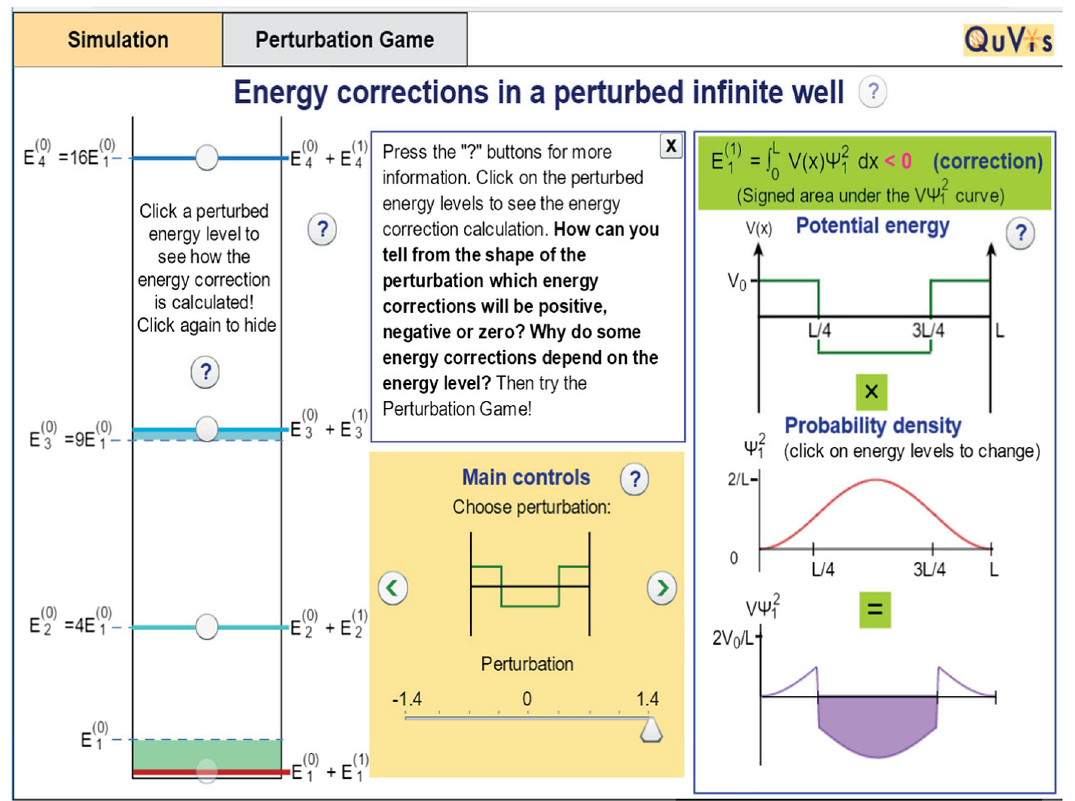
FIG. 2. A screenshot of the “ Energy corrections in a perturbed infinite well ” simulation.